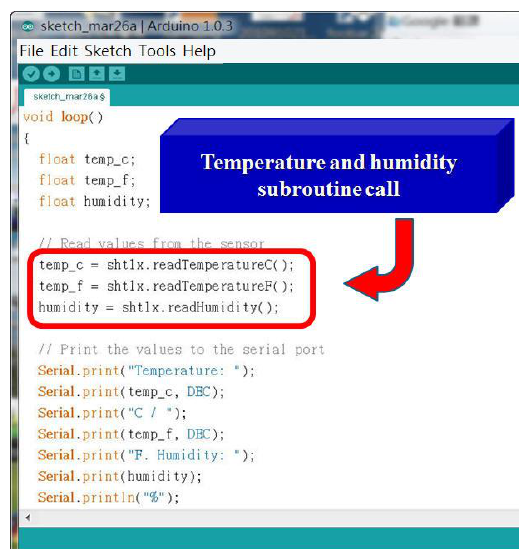
Figure 11. Part of the code for the measurement of temperature and humidity.